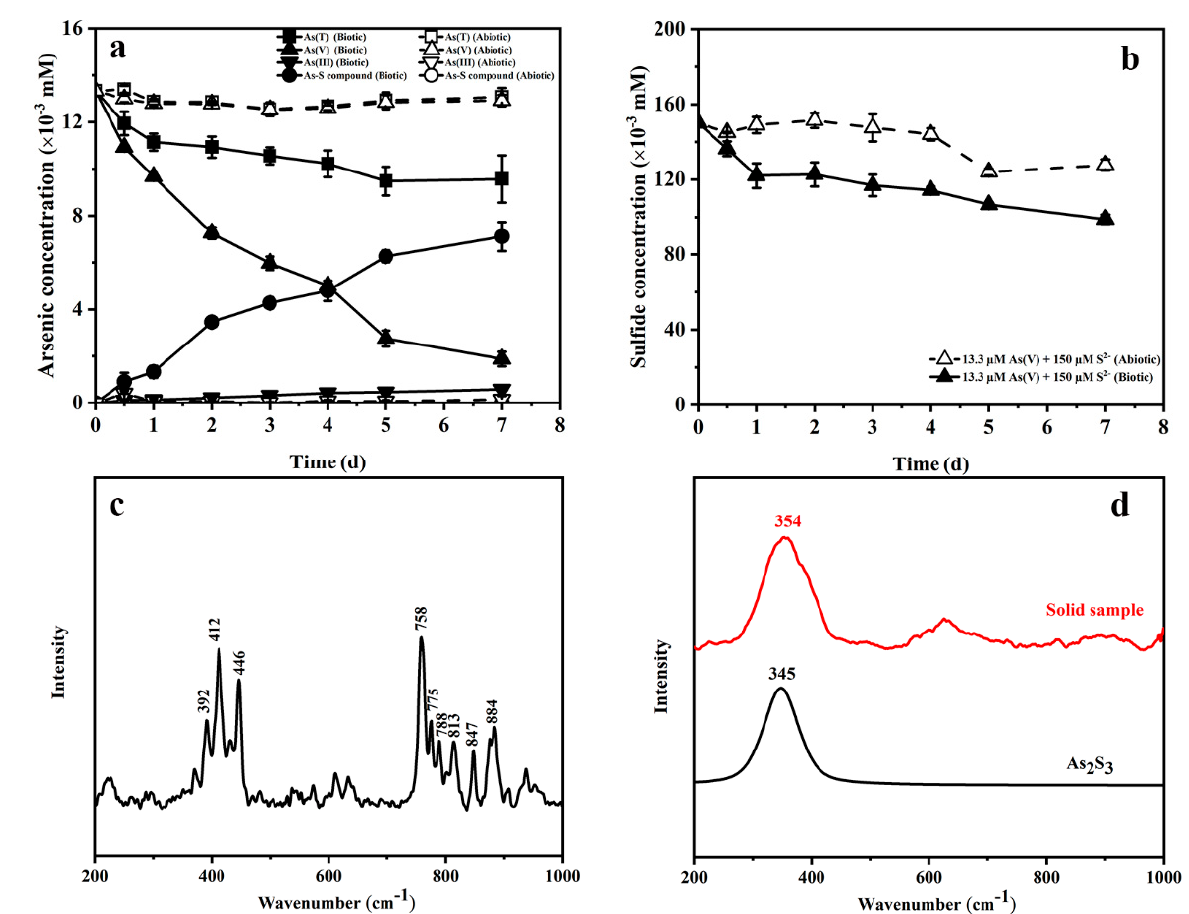
(Figure 2a,b). Interestingly, the concentration of As(III) was negligible.